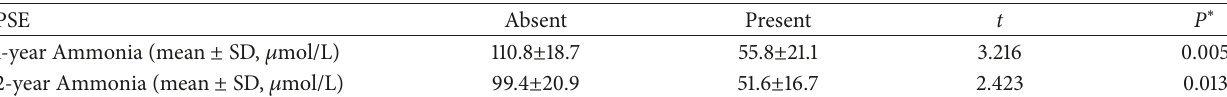
Table 5: Average blood ammonia level and